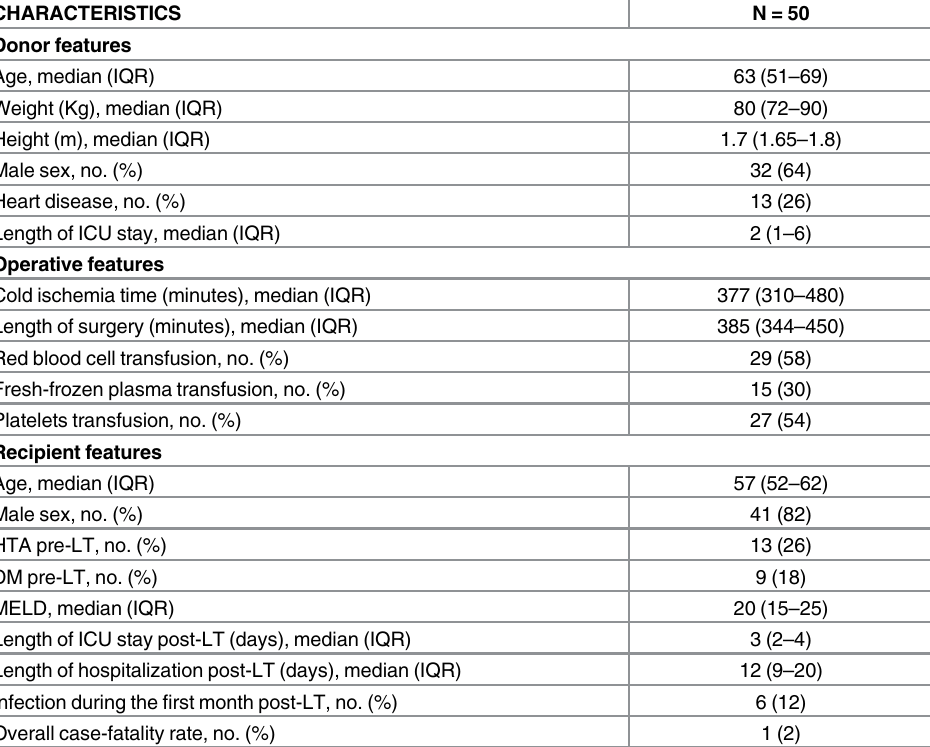
Table 1. Baseline liver donor and recipient characteristics, and operation features